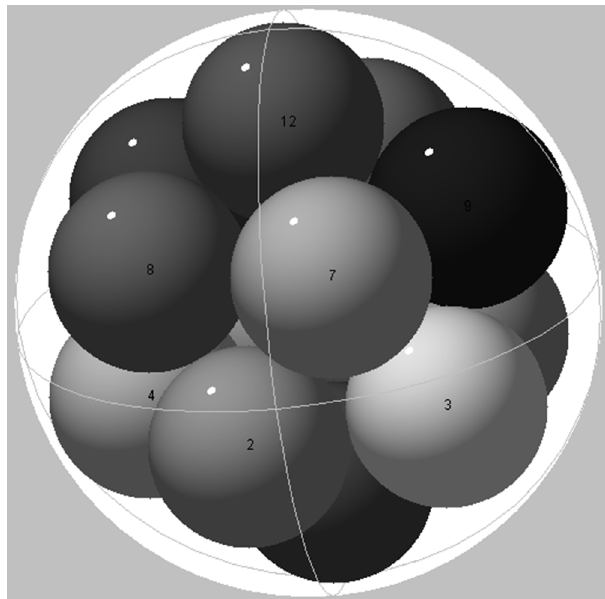
Fig. 4. Drawing of the dense 12 spheres hexagonal close packing inside a bigger sphere (source: https://en.wikipedia.org/wiki/